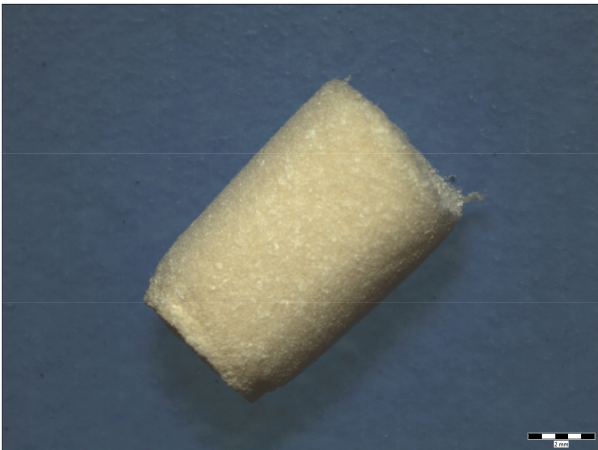
Figure 3. Macrostructure of scaffold before implantation. Scale bar: 2